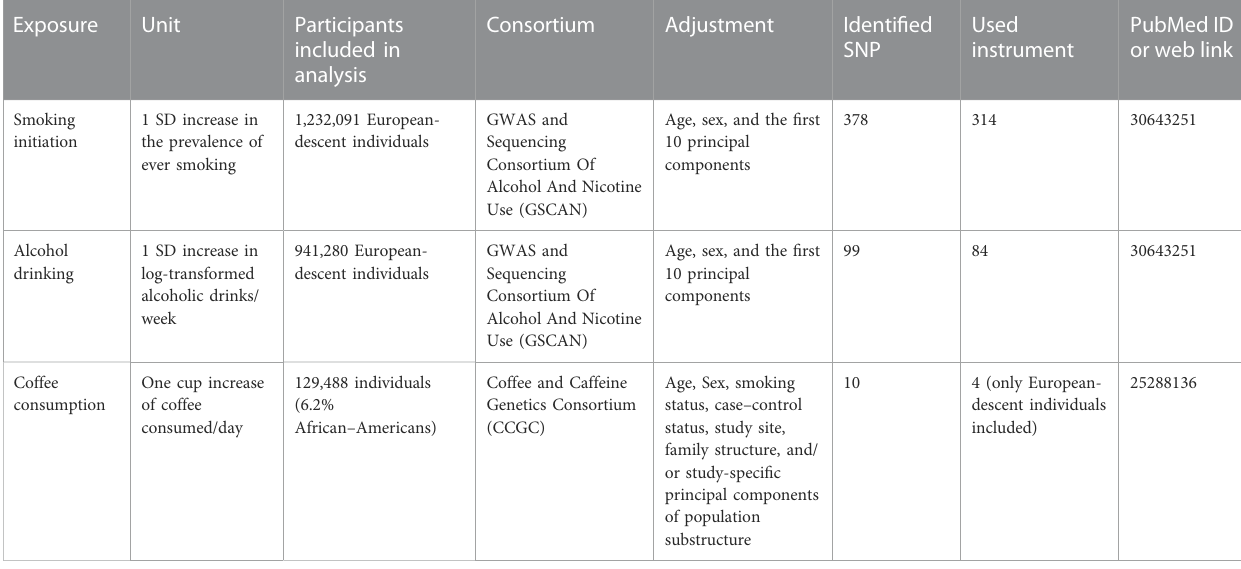
TABLE 1 Overview of the data sources of the instrumental variables used in the MR